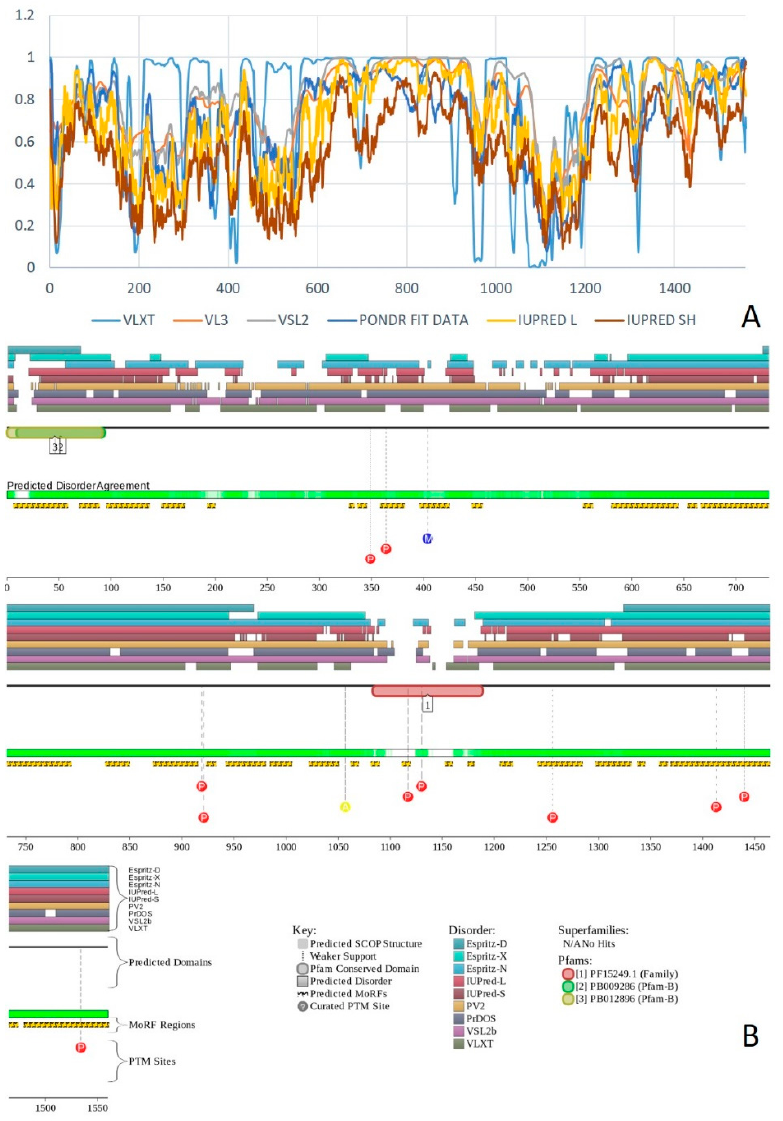
Figure 23. Structural and functional analysis of the human GLTSCR1 / BICRA protein (UniProt ID: Q9NZM4). ( A ) Intrinsic disorder profile of human GLTSCR1 / BICRA protein generated by six commonly used predictors of intrinsic disorder (PONDR ® VLXT, PONDR ® VL3, PONDR ® VSL2, PONDR ® FIT, IUPred_short, and IUPred_long). ( B ) D 2 P 2 functional disorder profile of the human GLTSCR1 / BICRA protein.